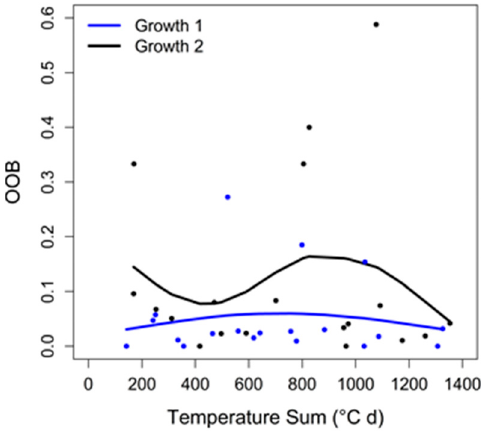
Figure 4. Random forests: Out-Of-Bag (OOB) errors of Growths 1 and 2.